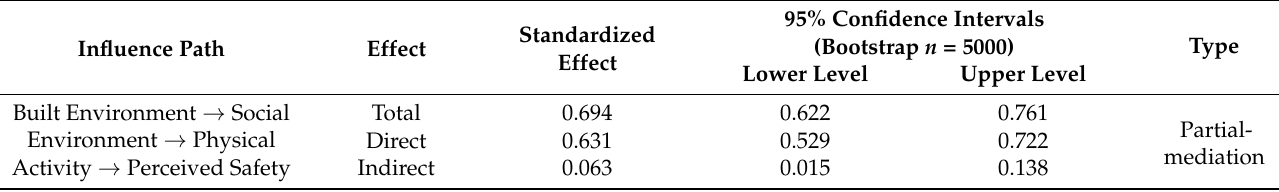
Table 4. Bootstrap analysis of mediated